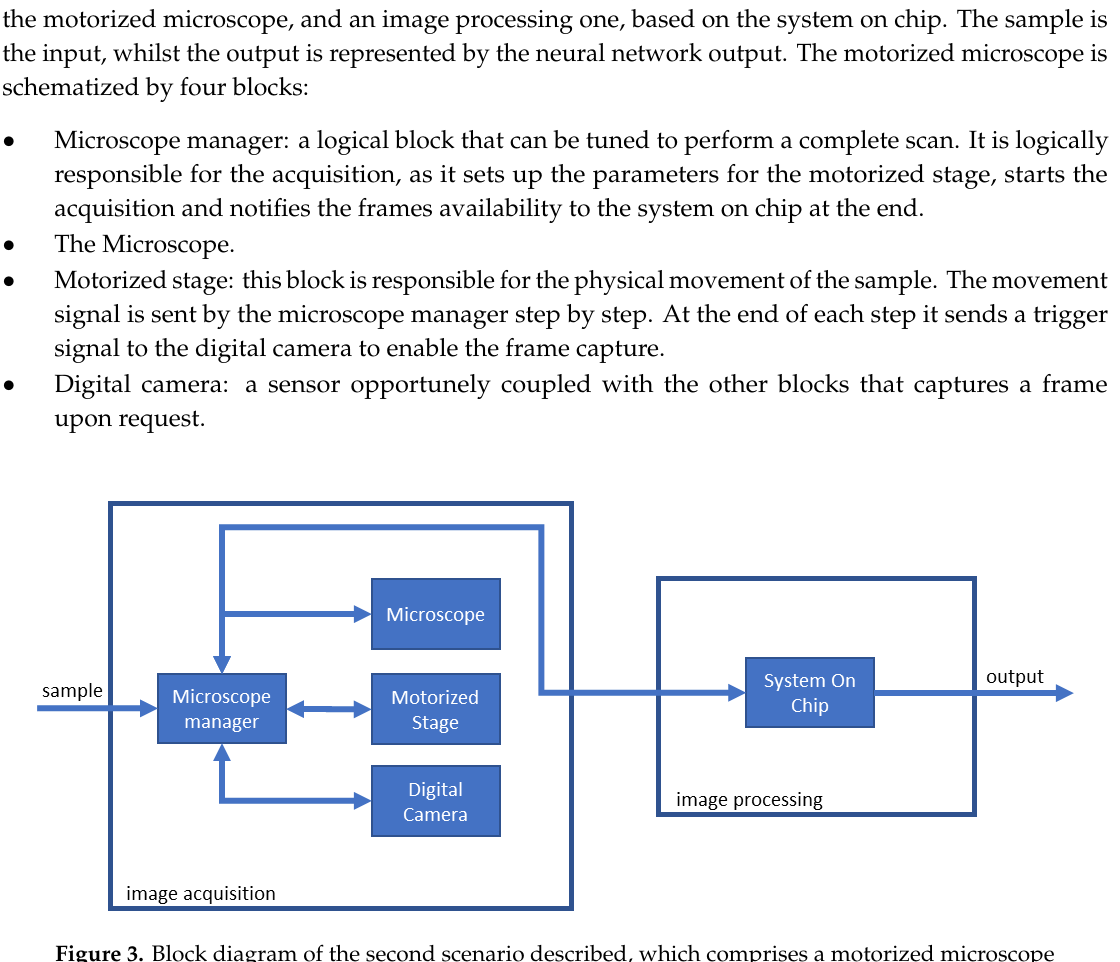
Figure 3. Block diagram of the second scenario described, which comprises a motorized microscope for the “image acquisition” and a system on ch ip board to perform “image